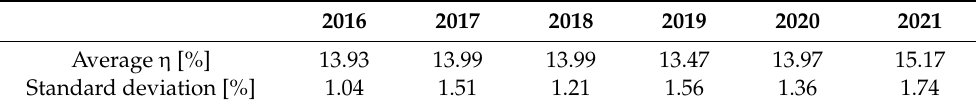
Figure 14. Comparison between real power output and two models forecasting for three cloudy ( a ) and three sunny days ( b ) for 2021. Table 1. Statistical and energy metrics.